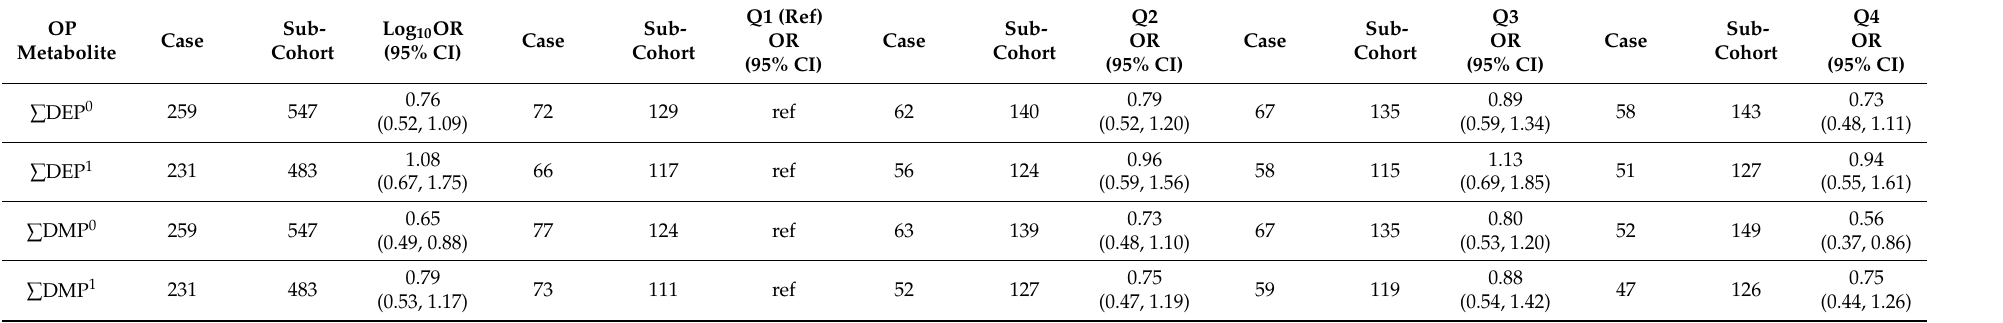
Table 4. Associations between prenatal urinary organophosphorus-pesticide metabolite concentrations and child’s preschool ADHD in a nested case–cohort study of the Norwegian Mother, Father and Child Cohort (MoBa), birth years